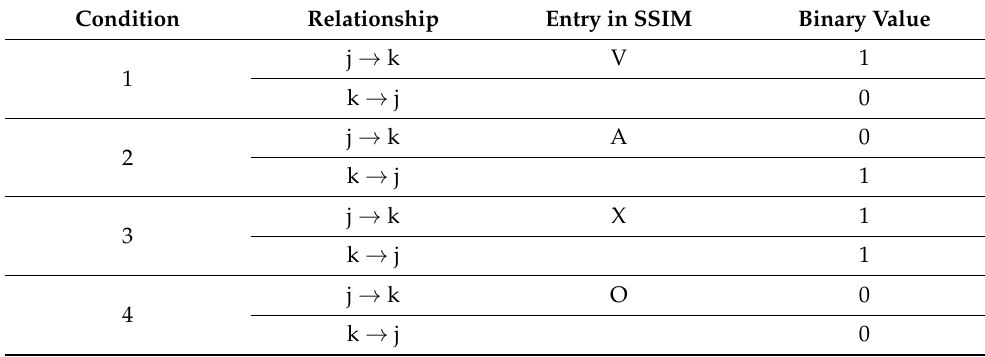
Table 3. Initial reachability